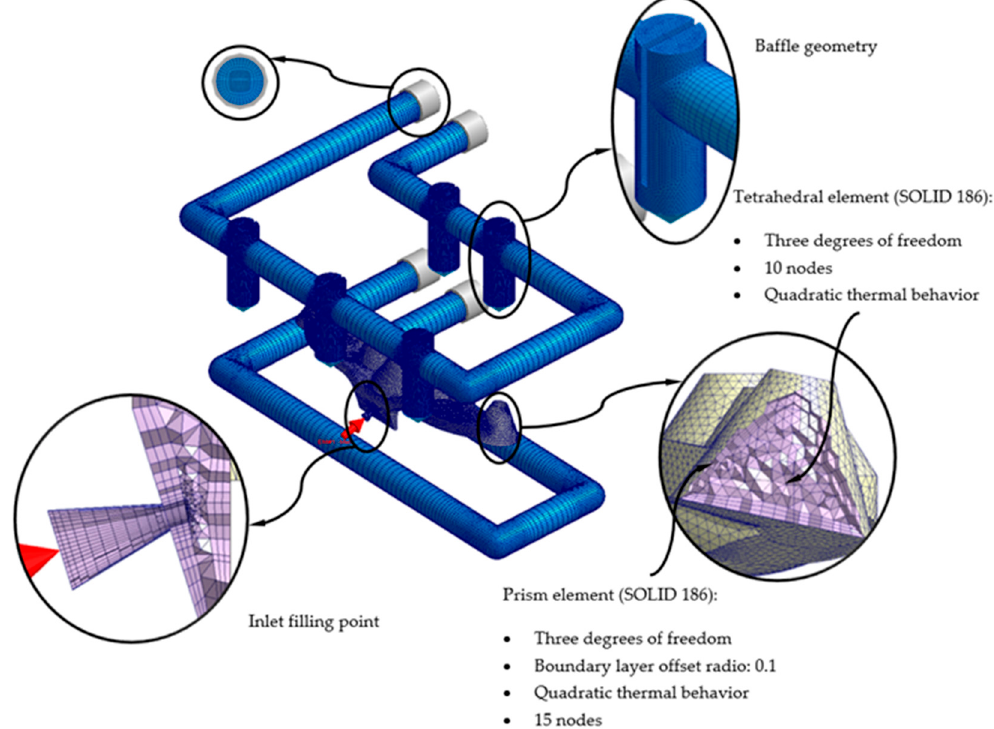
Figure 16. Mesh details for the traditional cooling solution.